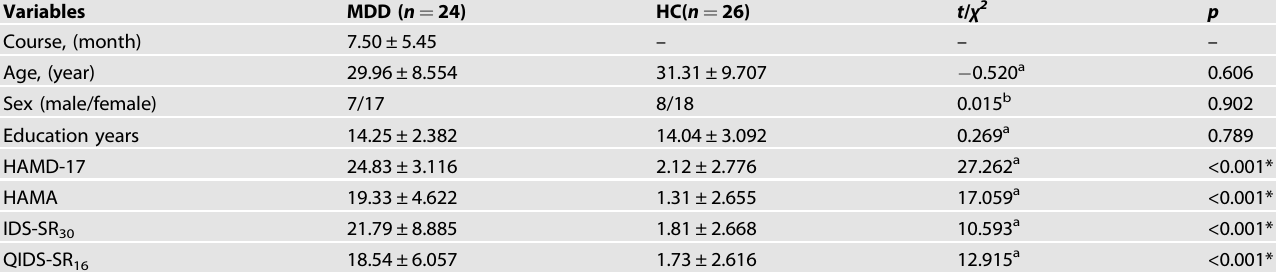
Table 1. Detailed clinical characteristics of the